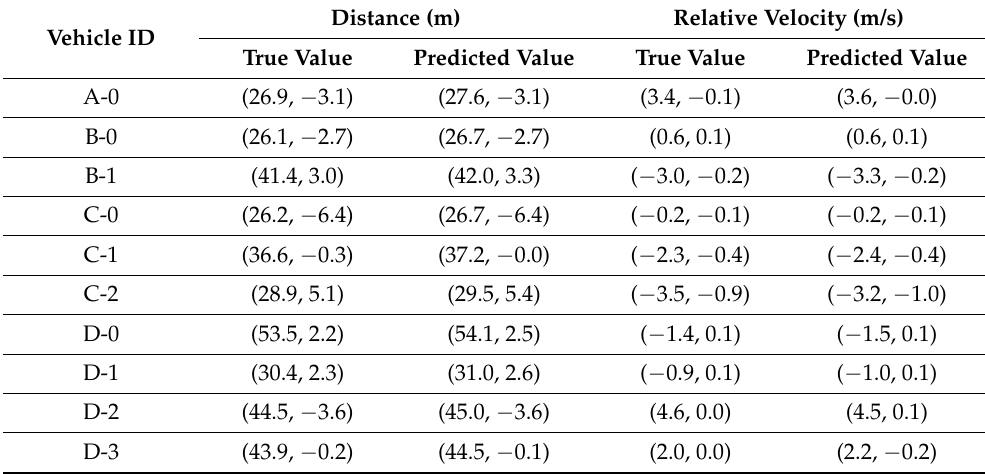
Figure 4. Qualitative visualization results for the Tusimple dataset. Figures ( a – d ) are typical feature maps extracted from the Tusimple dataset. Table 5. Predicted distance velocity estimates obtained corresponding to Figure 4.